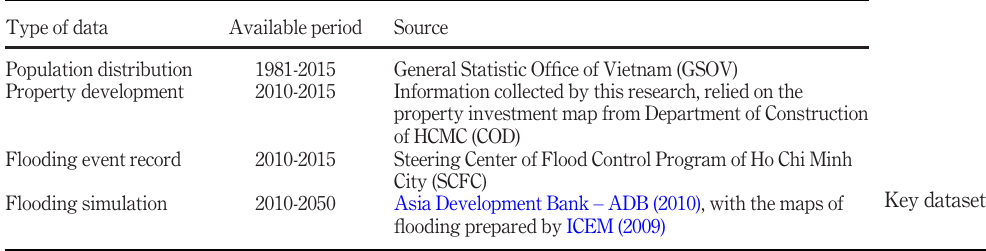
Table I. Key datasets used for